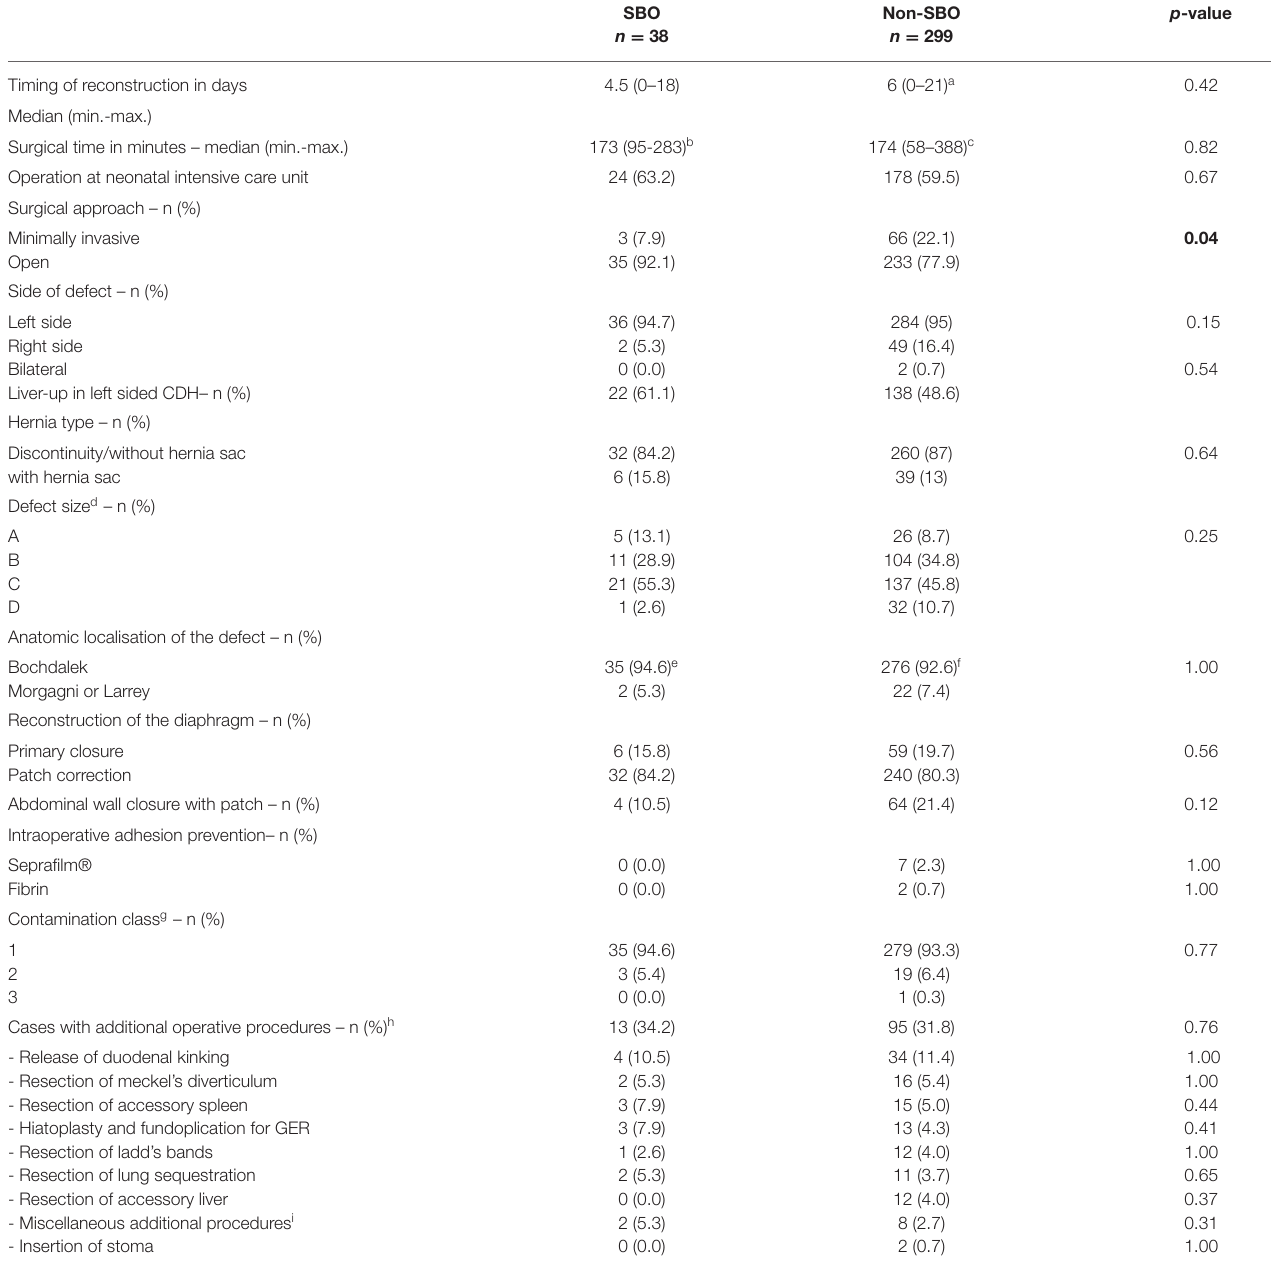
TABLE 3 | Differences in surgical characteristics and intraoperative findings between patients with SBO and non-SBO.